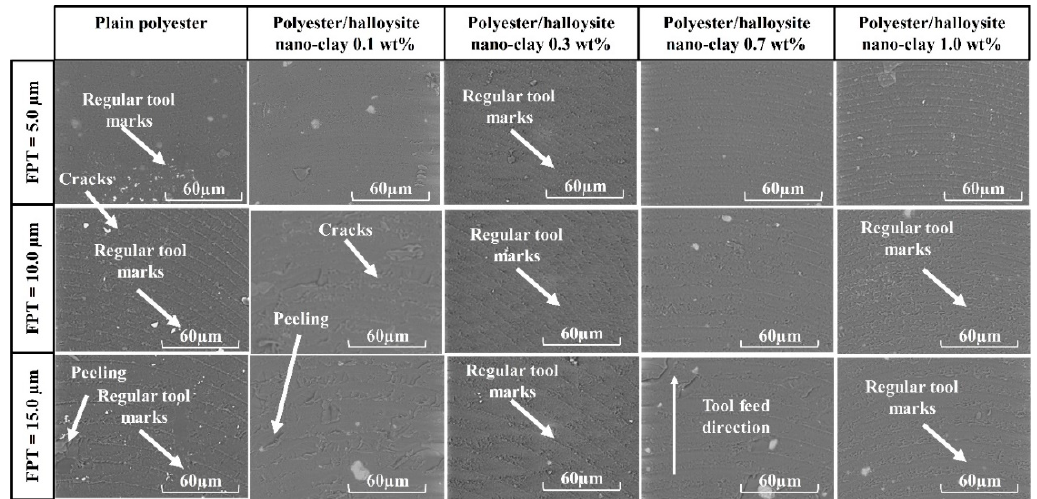
Figure 12. Bottom surface of machined slot at FPT = 5.0, 10.0, and 15.0 µ m (600 × ).